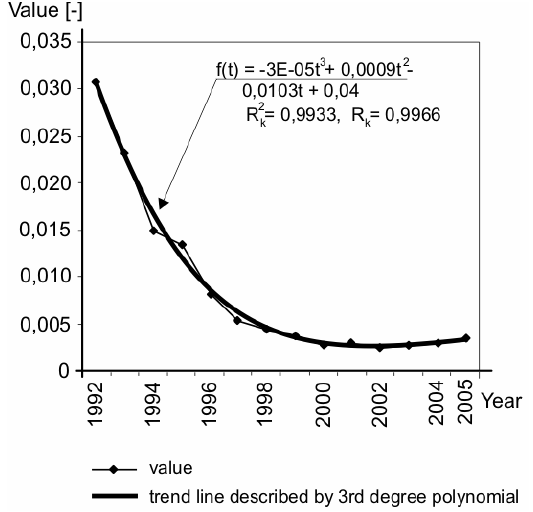
Table 4. Trend functions and determination and